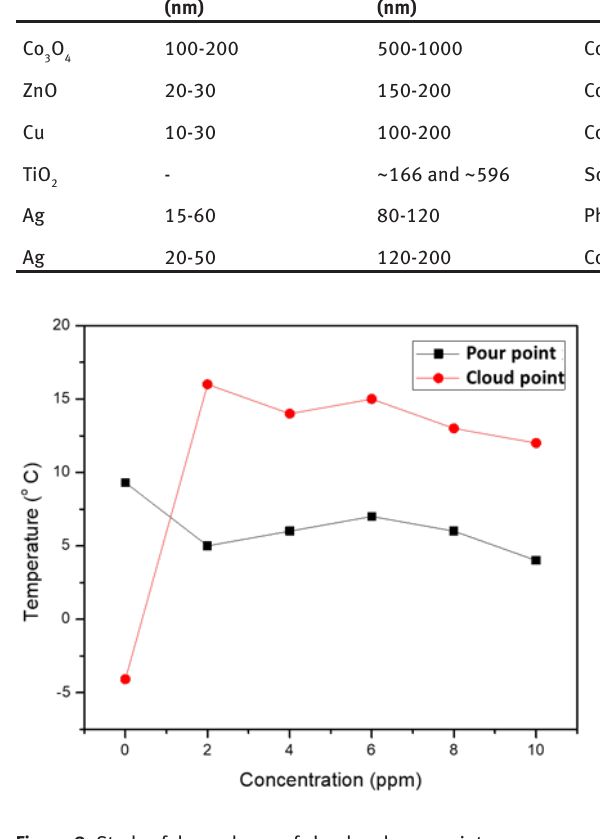
Figure 8: Study of dependence of cloud and pour points on concentration of additive.